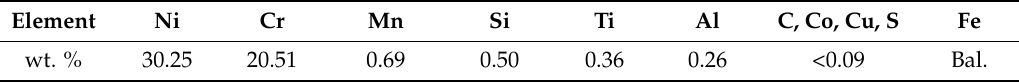
Table 1. Chemical composition of Alloy